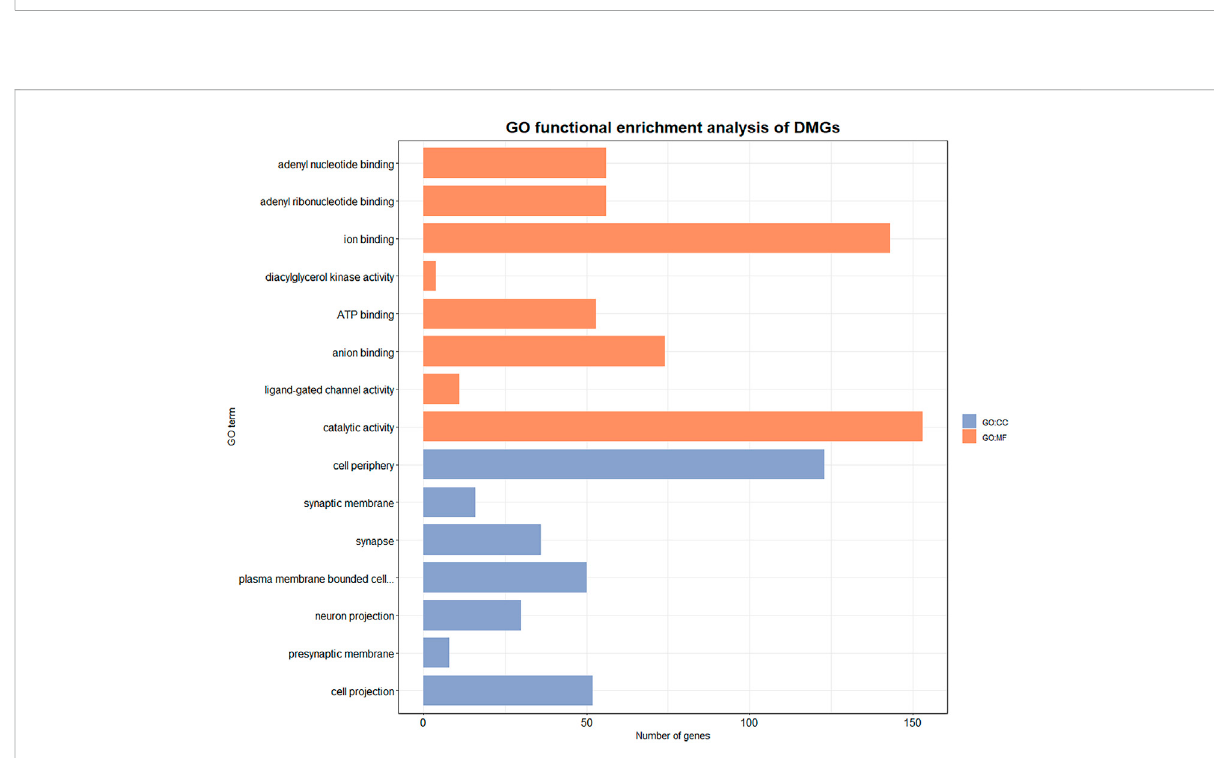
FIGURE 4 GO enrichment results of DMGs. Orange entries belong to molecular function, blue entries belong to cellular component. X axis indicates the number of genes involved in the GO enriched items, Y axis indicates the name of the